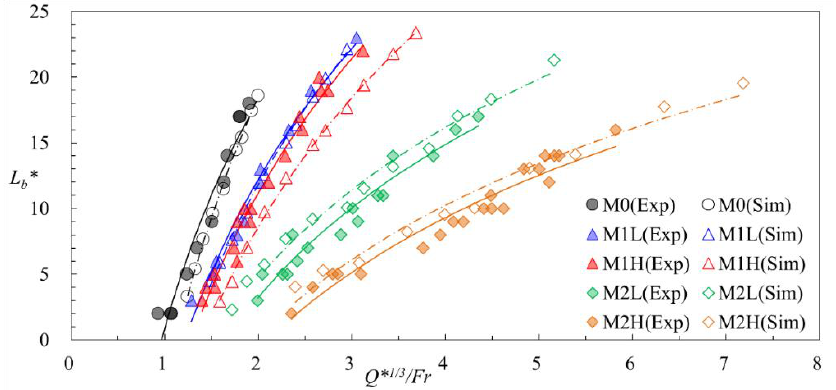
Figure 13. Comparison of the simulated and experimental results for the relationship between L b * and Q* 1 / 3 / Fr .